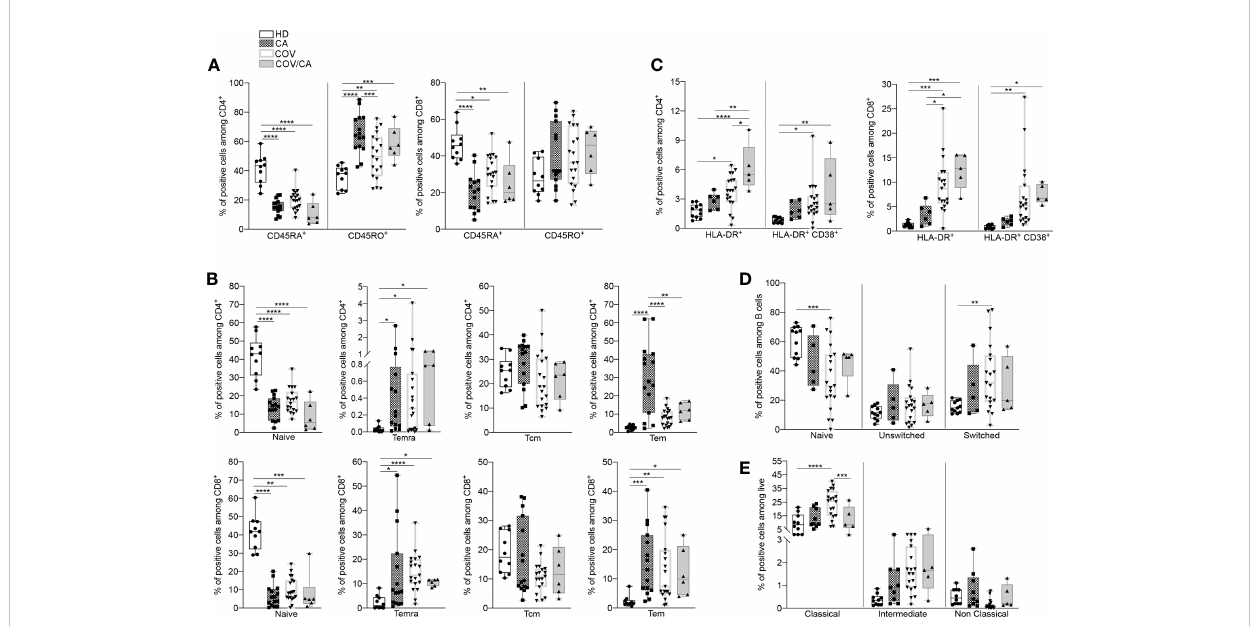
FIGURE 2 Cancer and COVID-19 affect the activation state of circulating immune cell subsets. (A) Box-and-whisker plots representing frequencies of CD45RA + and CD45RO + cells in CD4 + (left) and CD8 + (right) populations in freshly isolated PBMCs from HD, CA, COV and COV/CA patients (HD ( n = 10), CA ( n = 15), COV ( n = 19) and COV/CA ( n = 6)). (B, C) Box-and-whisker plots representing proportions of indicated lymphoid cell subsets (i.e., naïve, Temra, Tcm, Tem) in CD4 + (B, top) and CD8 + ( B , bottom) populations, (HD ( n = 10), CA ( n = 15), COV ( n = 19) and COV/CA ( n = 6), and of HLA-DR + and CD38 + /HLA-DR CD4 + ( C , left) and CD8 + ( C , right) T cells in freshly isolated PBMCs as above (HD ( n = 10), CA ( n = 6), COV ( n = 19) and COV/CA ( n = 5)). (D, E) Box-and-whisker plots representing frequencies of indicated (D) B cell subsets (naïve, switched, and unswitched) (HD ( n = 11), CA ( n = 5), COV ( n = 19) and COV/CA ( n = 5)) and (E) of monocytes subsets (classical, intermediate and non-classical) in freshly isolated PBMCs as above (HD ( n = 10), CA ( n = 9), COV ( n = 19) and COV/CA ( n = 5)). Boxplot representation (centre line, mean; box limits, upper and lower quartiles; whiskers, range; points, data points per patient). The statistical signi fi cance of differences between patient groups was calculated using two-way ANOVA with Sidak ’ s multiple comparisons test or one-way ANOVA followed by Tukey ’ s multiple comparison test or a Kruskal-Wallis test followed by Dunn ′ s multiple comparisons test. * P < 0.05, ** P < 0.01, *** P < 0.001, **** P < 0.0001 between selected relevant